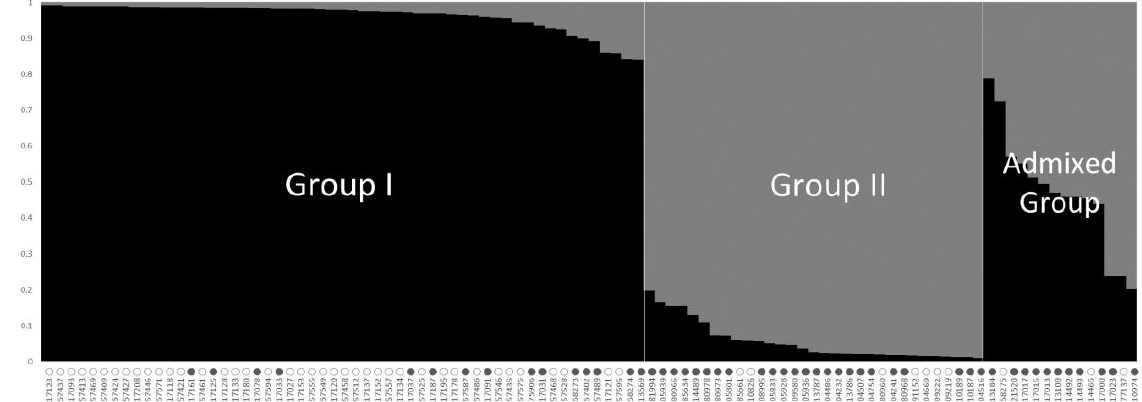
Figure 2. The population structure pattern for the highest Δ K value, K = 2, of 100 accessions of the cultivated var. frutescens based on 40 SSR markers. ○ : accessions of cultivated var. frutescens with a low total fatty acid content, ● : accessions of cultivated var. frutescens with high total fatty acid content.